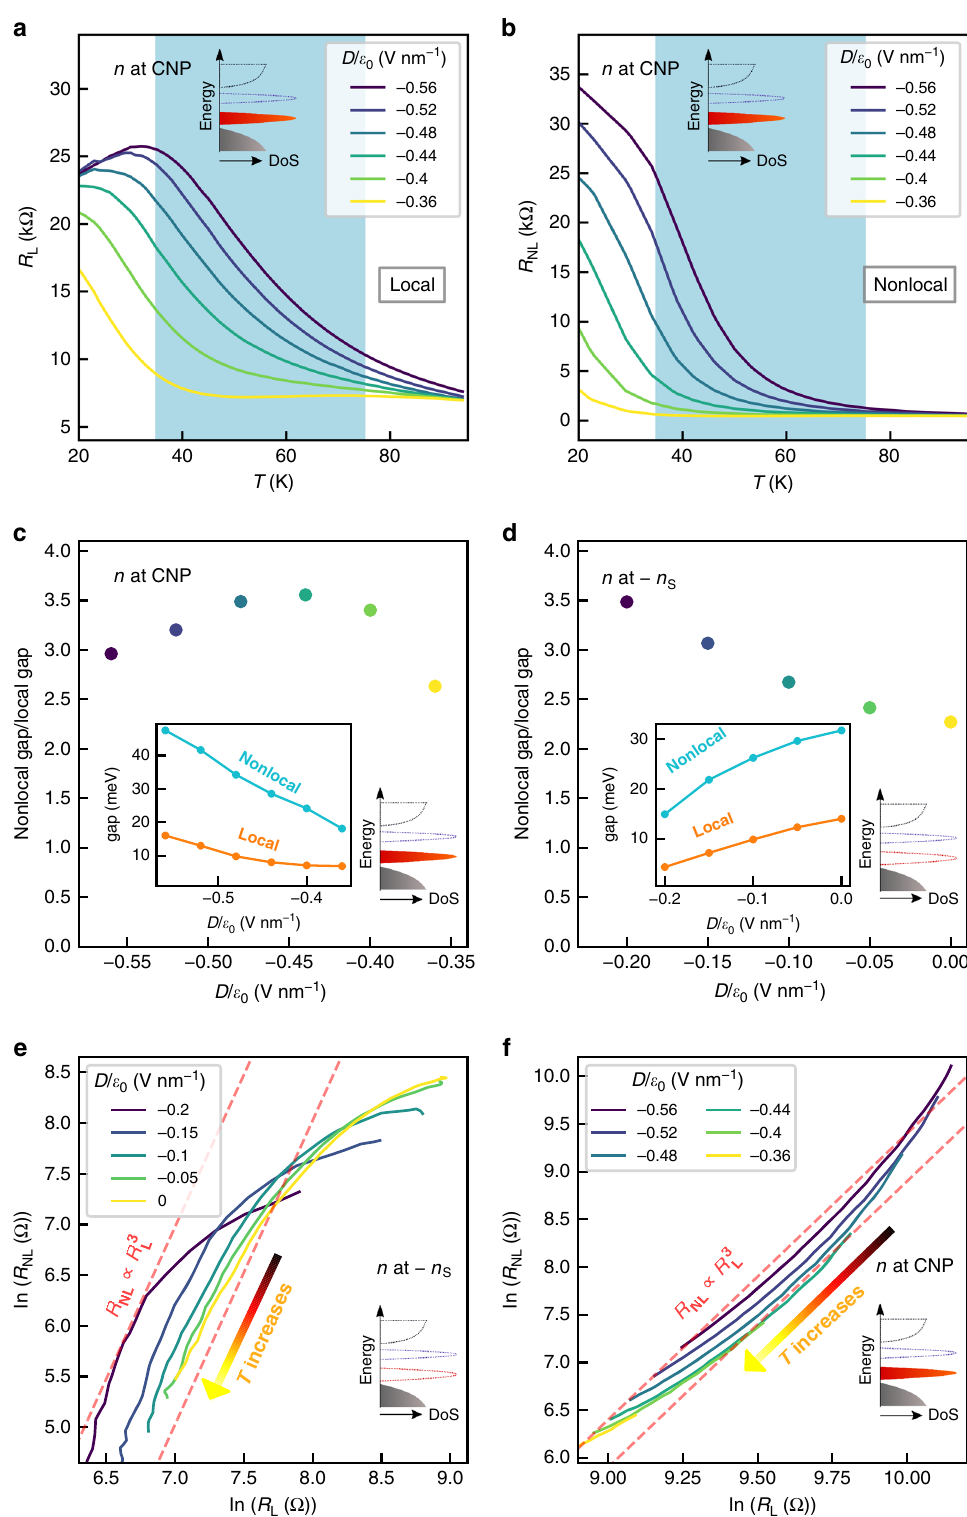
Fig. 3 Temperature dependence and scaling of local and nonlocal resistance. Inset of each panel shows schematic of band fi lling in that measurement. a , b Variation of local and nonlocal resistance with temperature at CNP for different electric fi elds. The region shaded with blue color is governed by Arrhenius activation and is the region used to show scaling relation in f . c , d Ratio of activation gaps for local and nonlocal resistance for CNP ( c ) and the moiré peak at n = − n S ( d ). The colors of the data points in c correspond to the same D values as in a , b , f and those in d are same as in e . The gaps are extracted by fi tting Arrhenius activation equation to R vs T curves in the temperature range within 15 – 85 K. Insets show the variation of gaps with electric fi eld. The ratio, being close to 3, shows that R / R 3 , and thus strongly supports bulk valley transport. e , f The scaling of nonlocal resistance with local NL L resistance at different electric fi elds for n = − n S ( e ) and CNP ( f ). Here, temperature is used as a parameter to show the